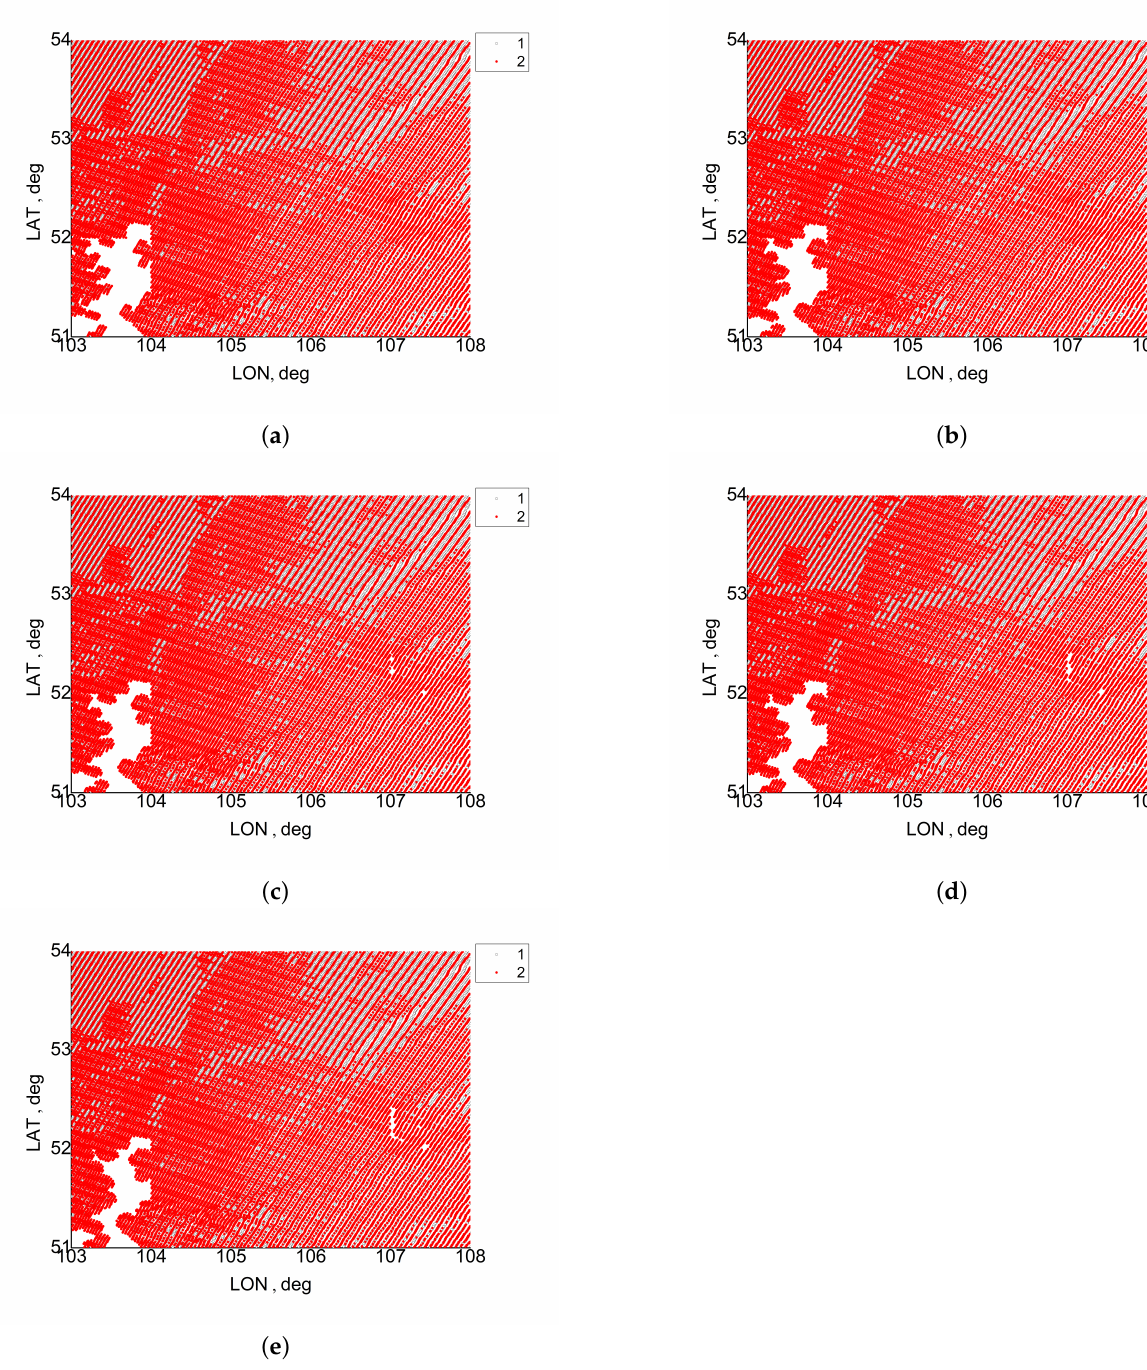
Figure 5. Masks of the cloud adjacency effect (CAE) on reflectance retrievals from MOIDS data for 05:00 UTC of 2 July 2021: ( a ) MODIS band 8, ( b ) MODIS band 3, ( c ) MODIS band 4, ( d ) MODIS band 1, ( e ) MODIS band 2; (1) cloud points, and (2) cloudless points with strong